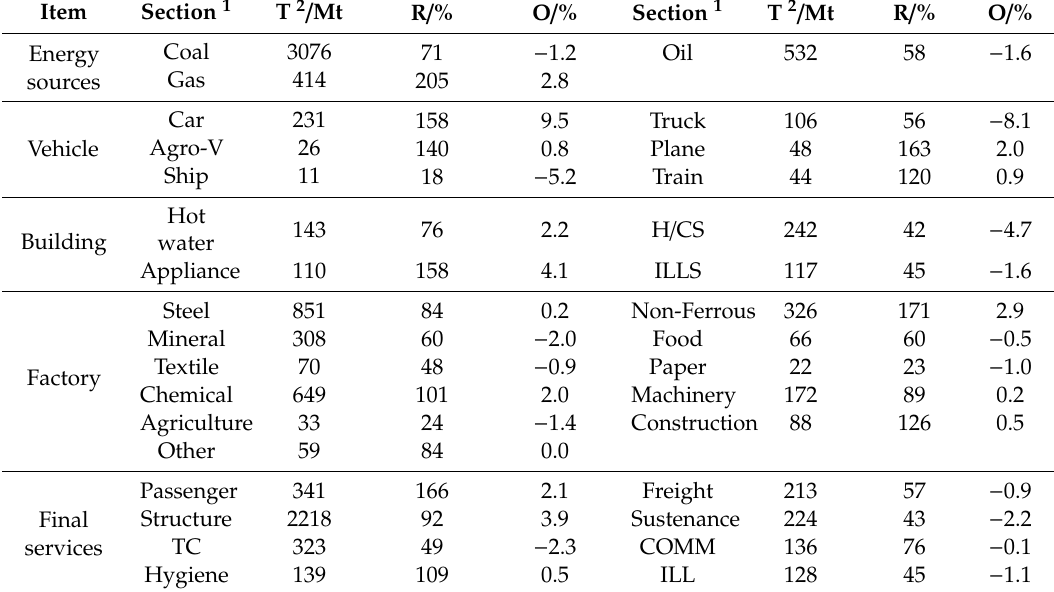
Table 3. The TRO index decomposition of relevant